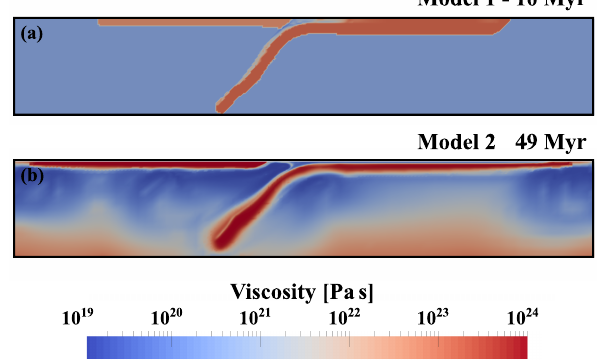
Figure 19. Viscosity snapshots of (a) model 1 and (b) model 2 at comparable moments in the respective subduction